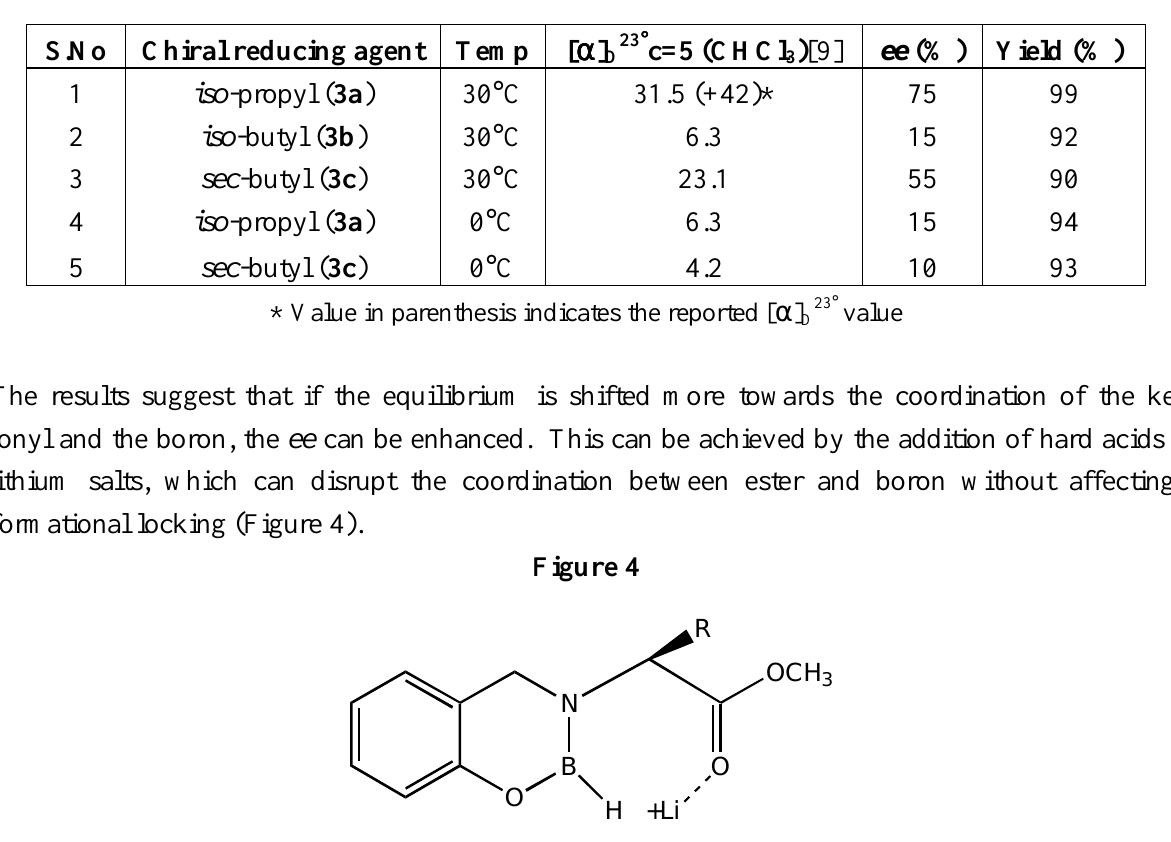
Table 1: Reduction of acetophenone using dihydrooxazaborins